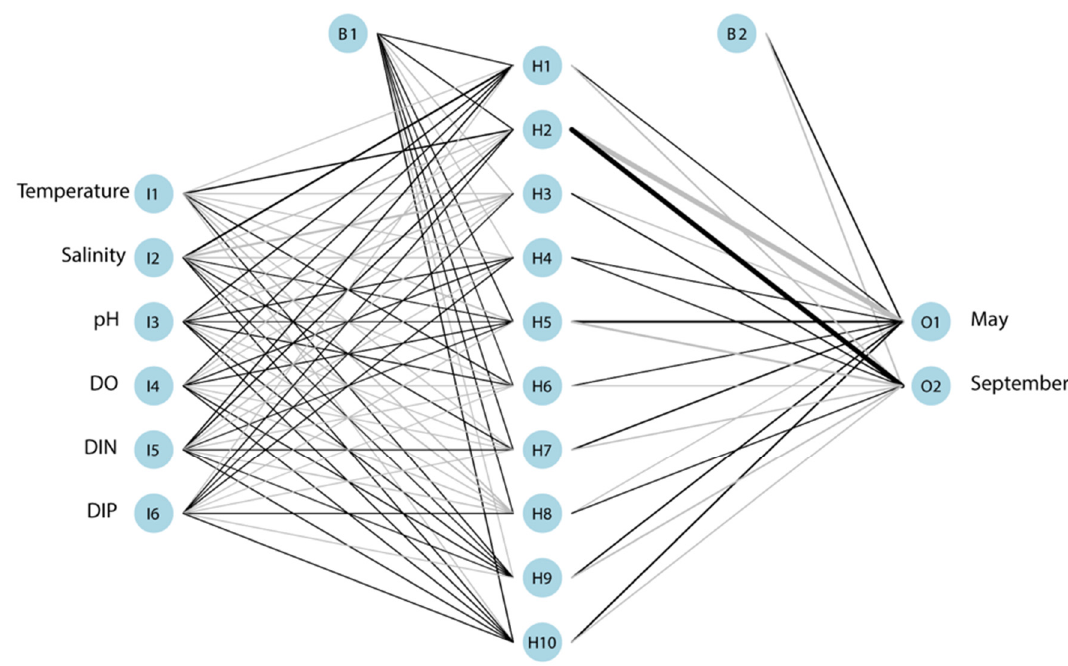
Figure 8. Artificial neural network (ANN) for predicting phytoplankton abundance in May and September as a function of water environmental variables. The thickness of the lines joining the neurons is proportional to the strength of the connection weight. Black lines denote positive connections, and gray lines denote negative connections. One hidden layer was applied. Circles with B indicate additional inputs with layers, and bias are not affected by the previous layer.